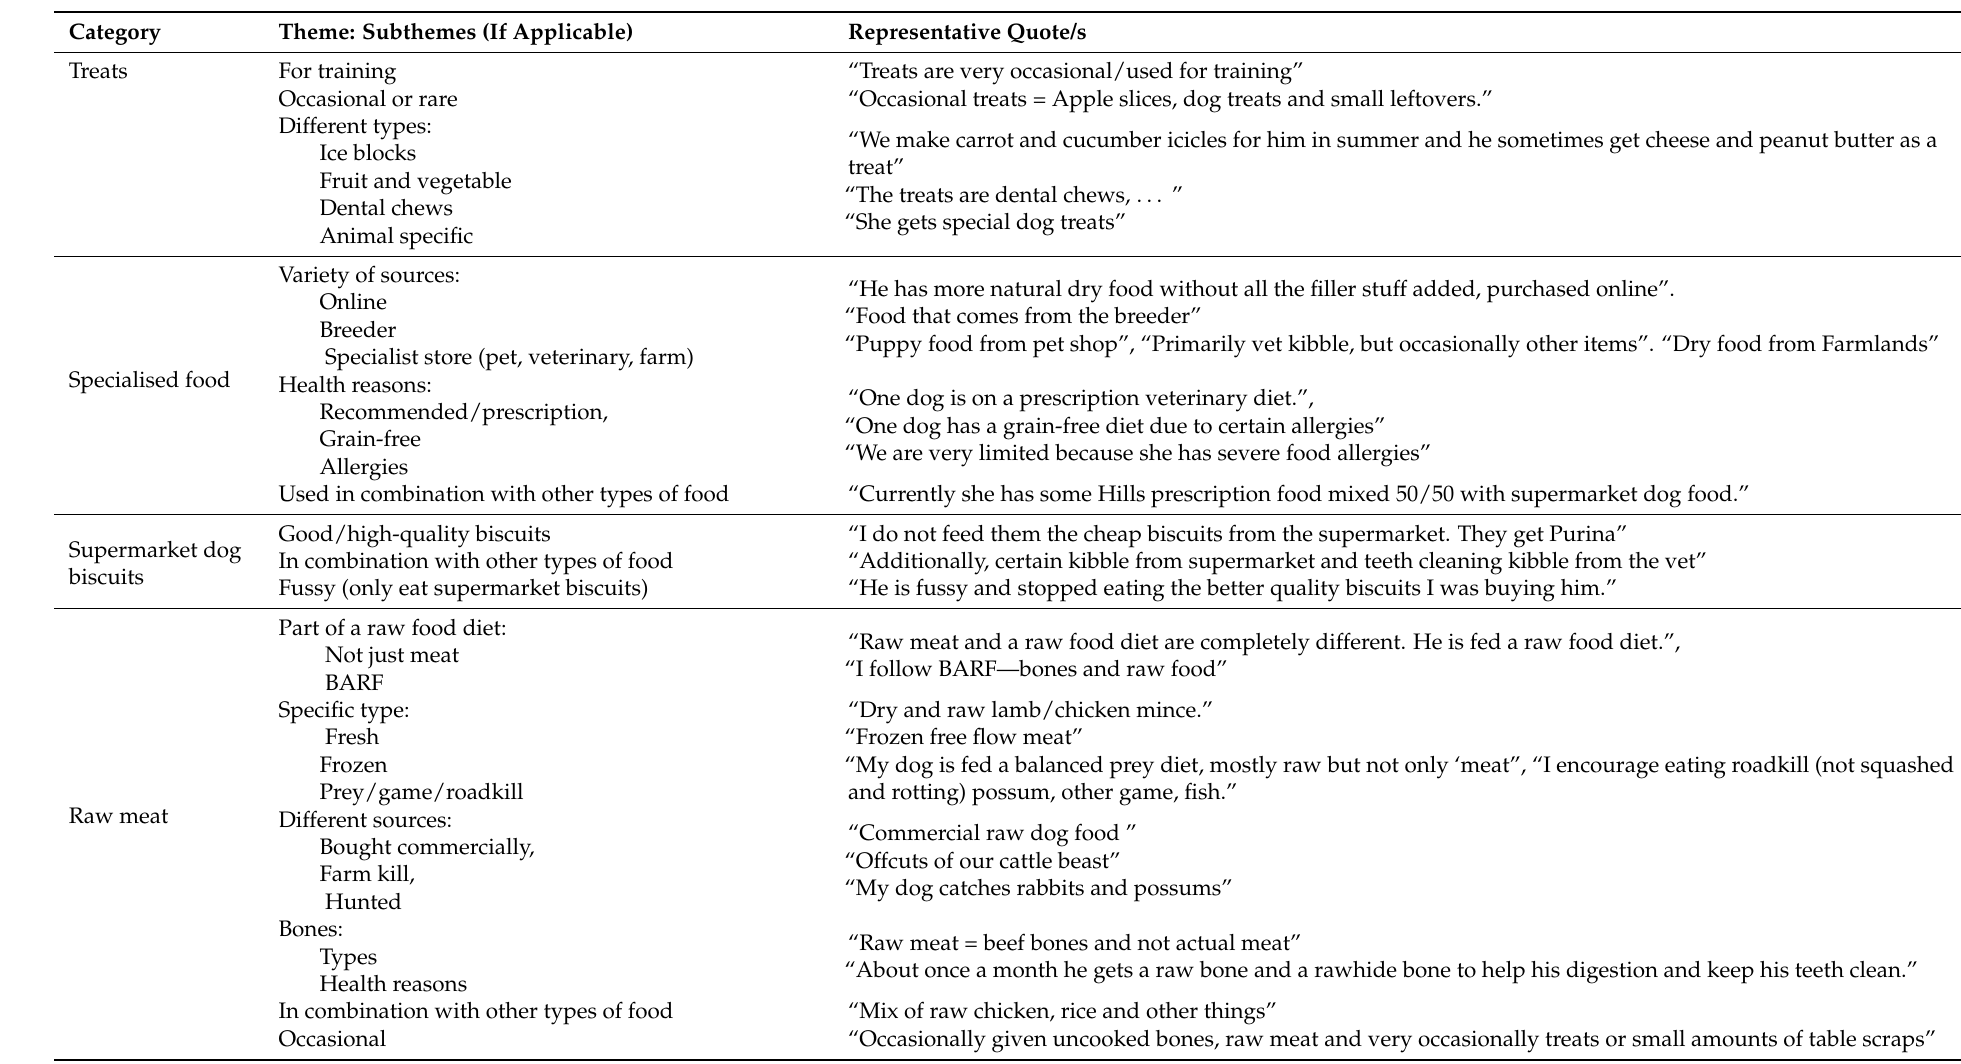
Table 2. Thematic analysis of comments provided about respondents’ dog diets in the EIT Pet Survey 2019.